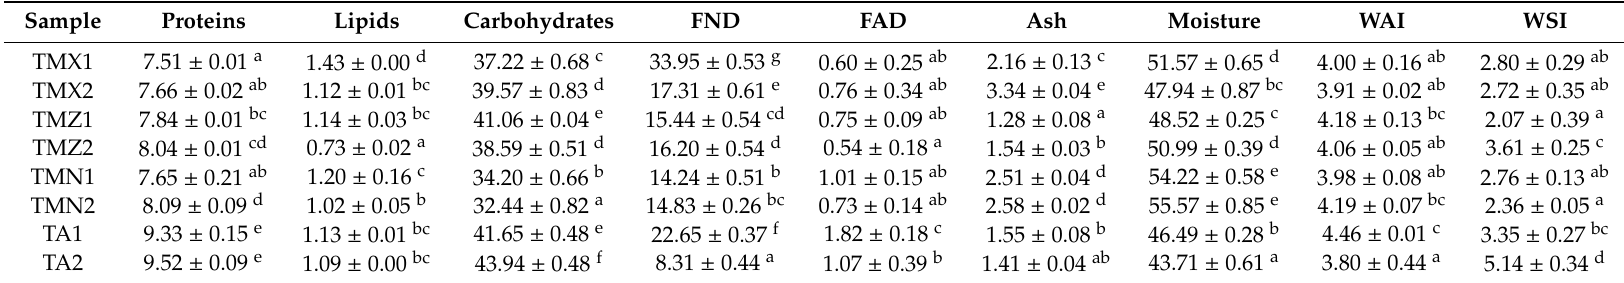
Table 7. Chemical parameters of tortilla samples expressed as g / 100